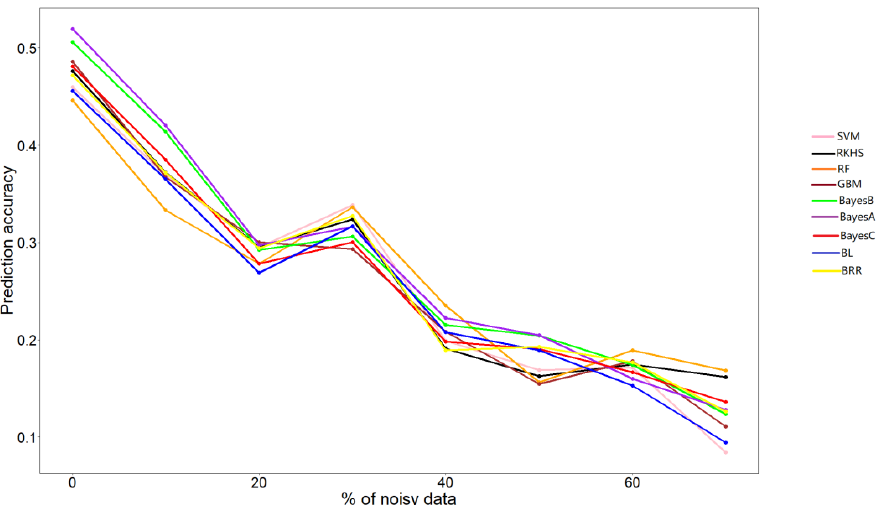
Figure 2. Prediction accuracy of each algorithm when noisy data is added to the phenotype. The O. niloticus weight-trait dataset was used. The percentage of noisy data included in the phenotype data and the prediction efficiency evaluated by Pearson correlation coefficient are represented in the X and Y axes, respectively.